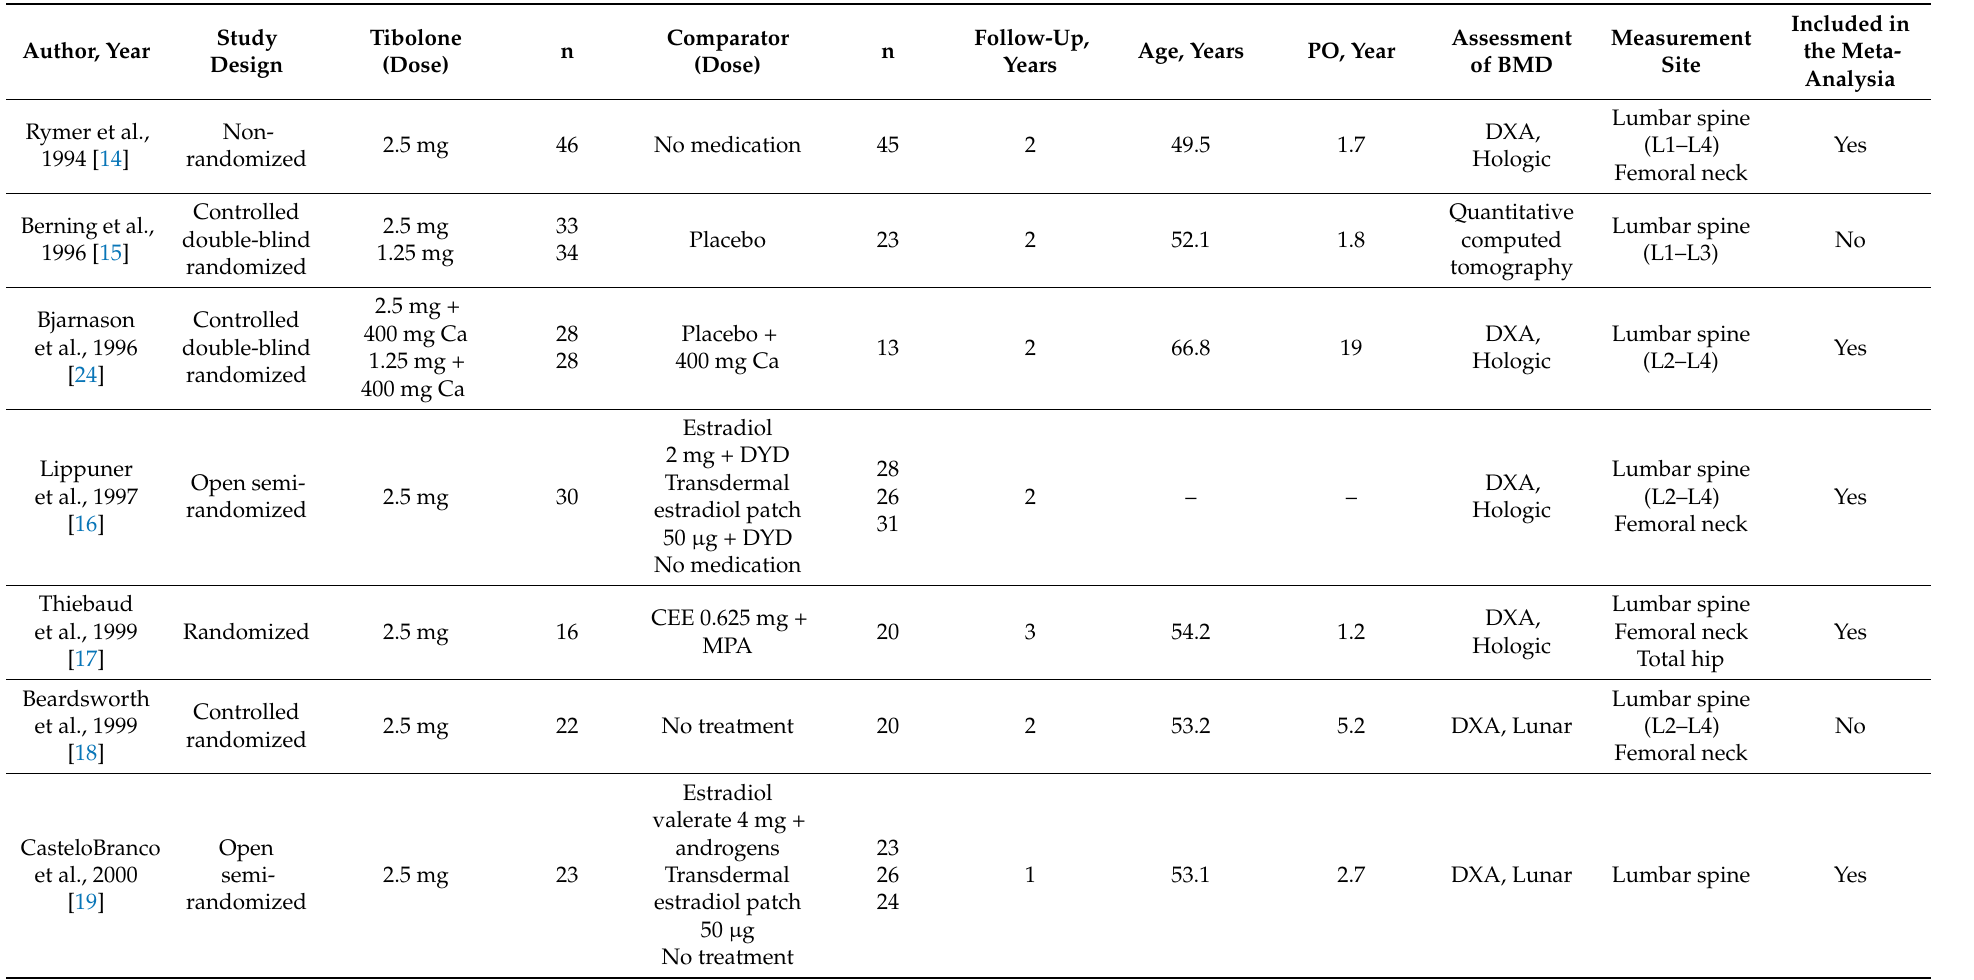
Table 1. Characteristics of the included studies (n =